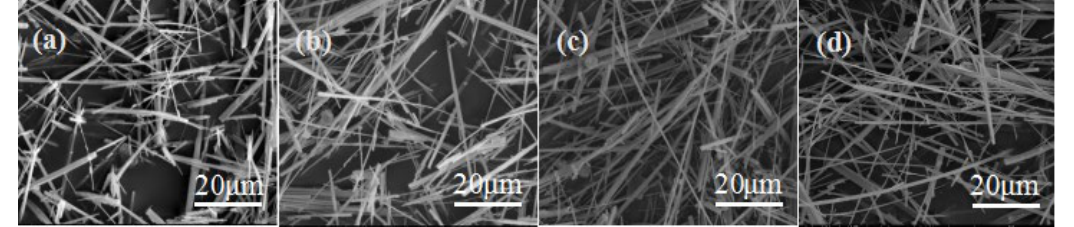
Figure 7. ESEM photos of CSHW in different water–material ratios: ( a ) 5:1, ( b ) 7:1, ( c ) 9:1, ( d ) 11:1.